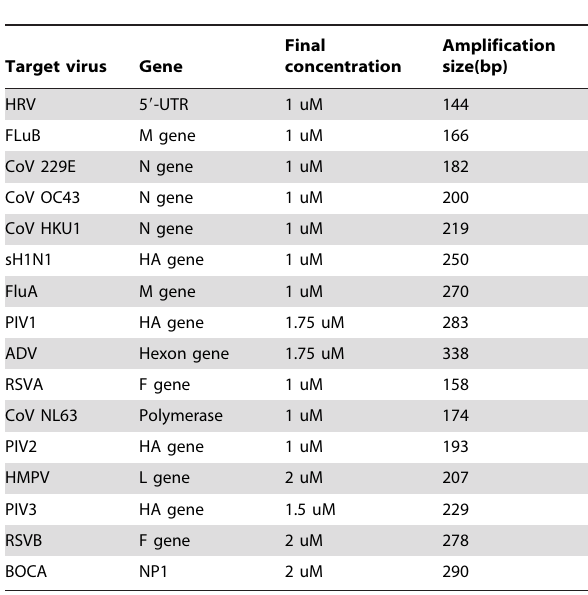
Table 4. Primers information in this